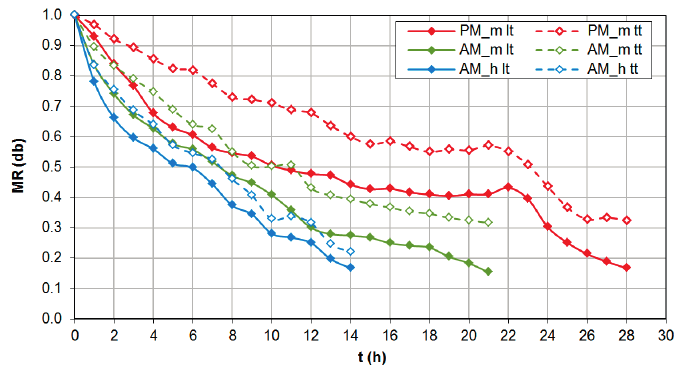
Figure 11. MR (db) for different OP